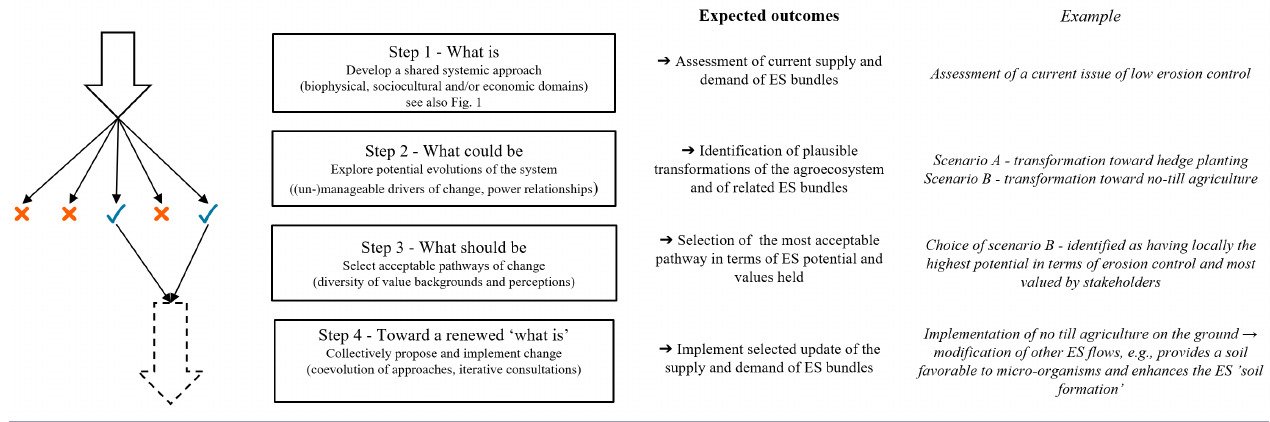
Fig. 1. A four-step, iterative, methodological framework to steer agroecological transitions based on integrated ES